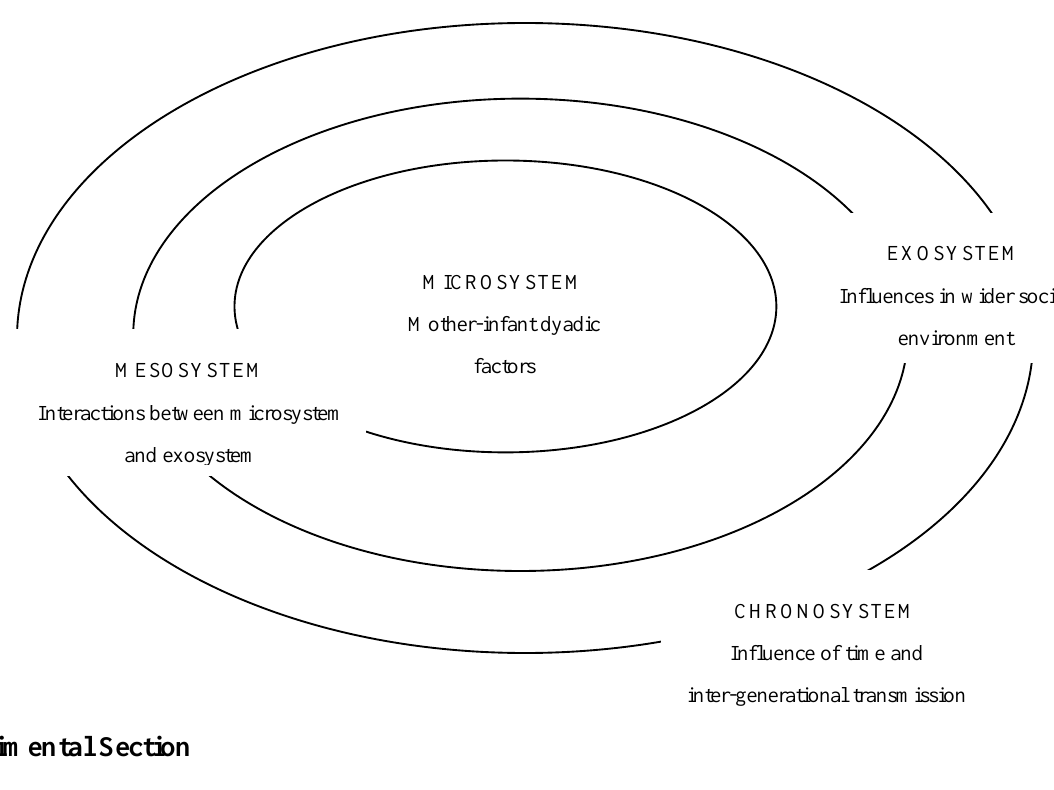
Figure 1. The Bronfenbrenner ecological